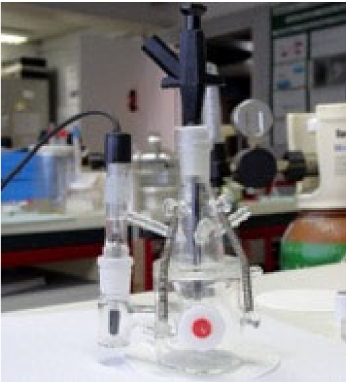
Figure 7. Electrochemical cell for the evaluation of the external surface.